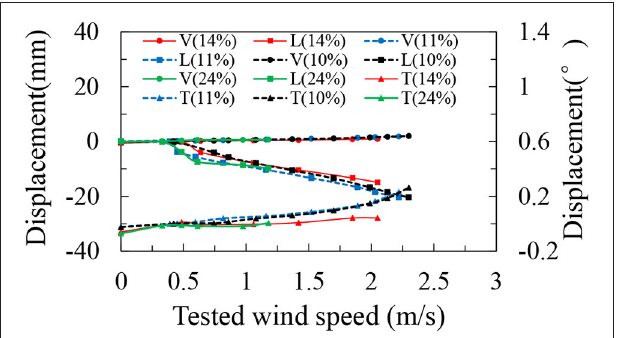
FIGURE 19 | R.M.S. responses under different turbulence intensities.